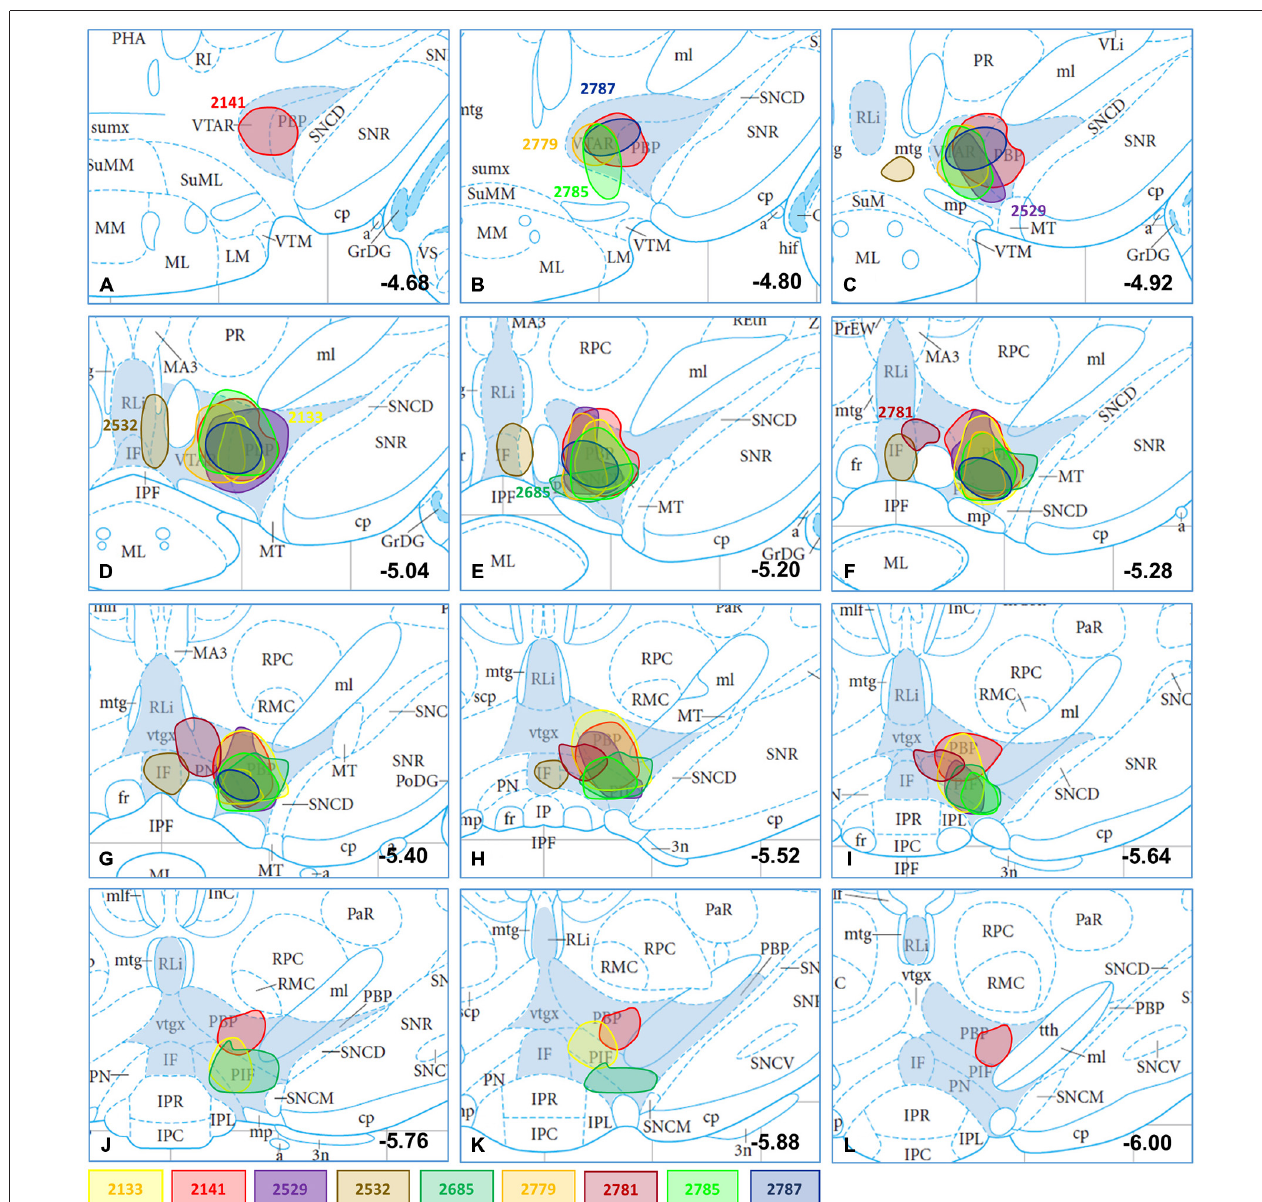
FIGURE 1 | CTB-immunoreactive injection sites plotted in mesencephalic section images; the location and dimension of selected injection sites (#2133, #2141, #2529, #2532, #2685, #2779, #2781, #2785, 2787) demonstrated with differently colored spots in atlas figures (Bregma levels from − 4.68 to − 6.00; A–L) according to Paxinos and Watson (2005). Subnuclei of the VTA (VTAR, PBP, PN, PIF, RLi, IF) are shaded in blue. The plots at different Bregma levels indicate the antero-posterior spread of the corresponding CTB deposit. The atlas figures modified were originally published in The Rat Brain in Stereotaxic Coordinates: The New Coronal Set. Fifth edition, George Paxinos and Charles Watson, Copyright Elsevier (2005) .